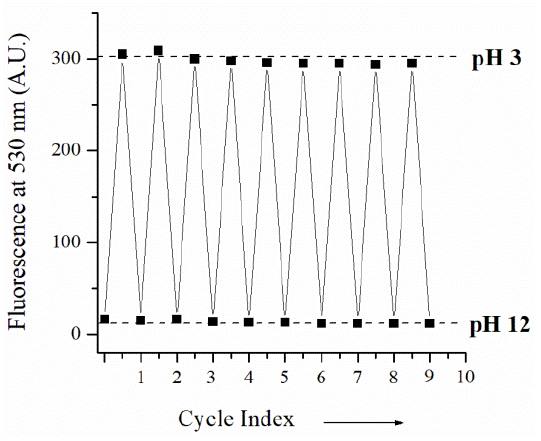
Figure 3. Cycle index of probe 3 .